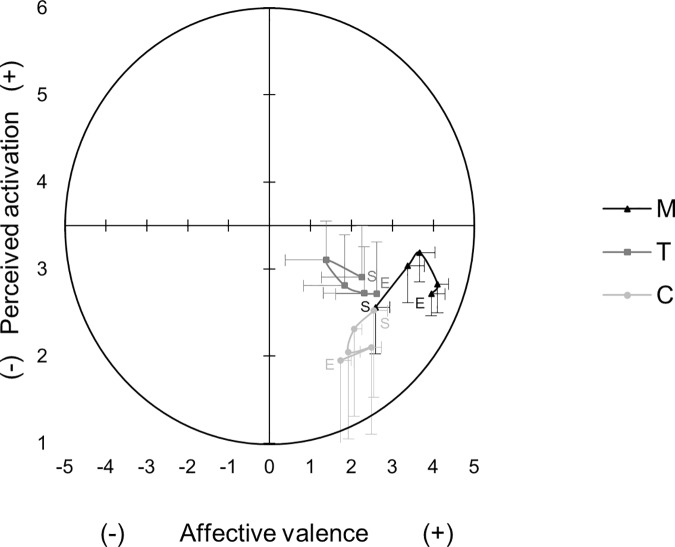
Mean affective valence and perceived activation over time in all conditions.M: outdoor mountain hiking, T: indoor treadmill walking, C: sedentary control condition, S: Start of the condition, E: End of the condition, error bars represent 95% CI.